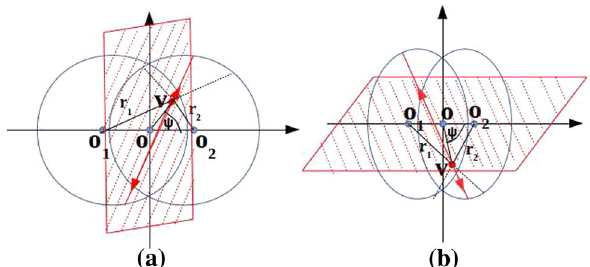
Fig. 4 Jet production for a tip–tip configuration, and b body–body configuration of U+U collisions in the plane of impact parameter b . O 1 and O 2 are the nucleus centers, OO 1 = OO 2 = b / 2. V is the jet production vertex and its coordinate will be ( r cos ψ, r sin ψ ) for tip–tip and body–body configuration both